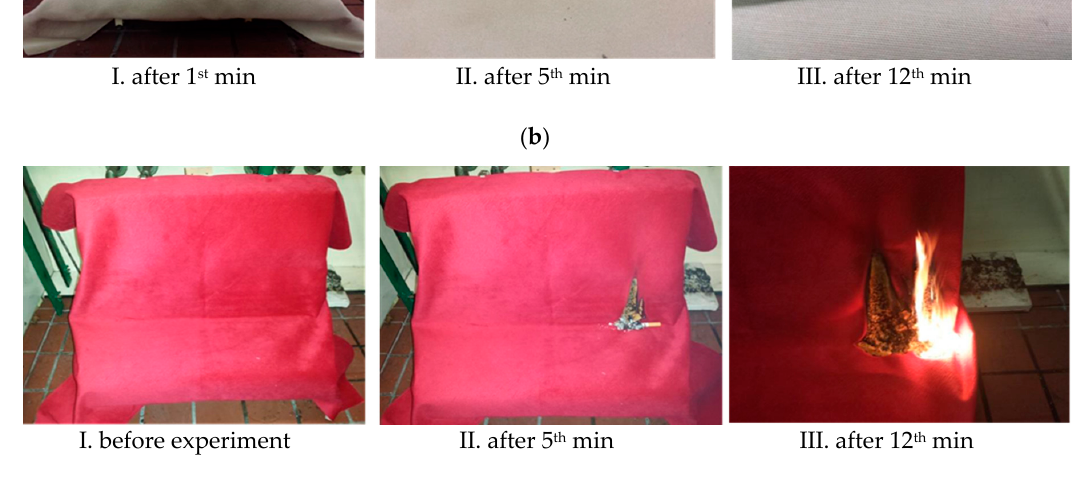
( b ) Figure 4. The experiment with Sample 2 using an equivalent to a match. ( a ) Ignition by the equivalent of match, and ( b ) residual after experiment.